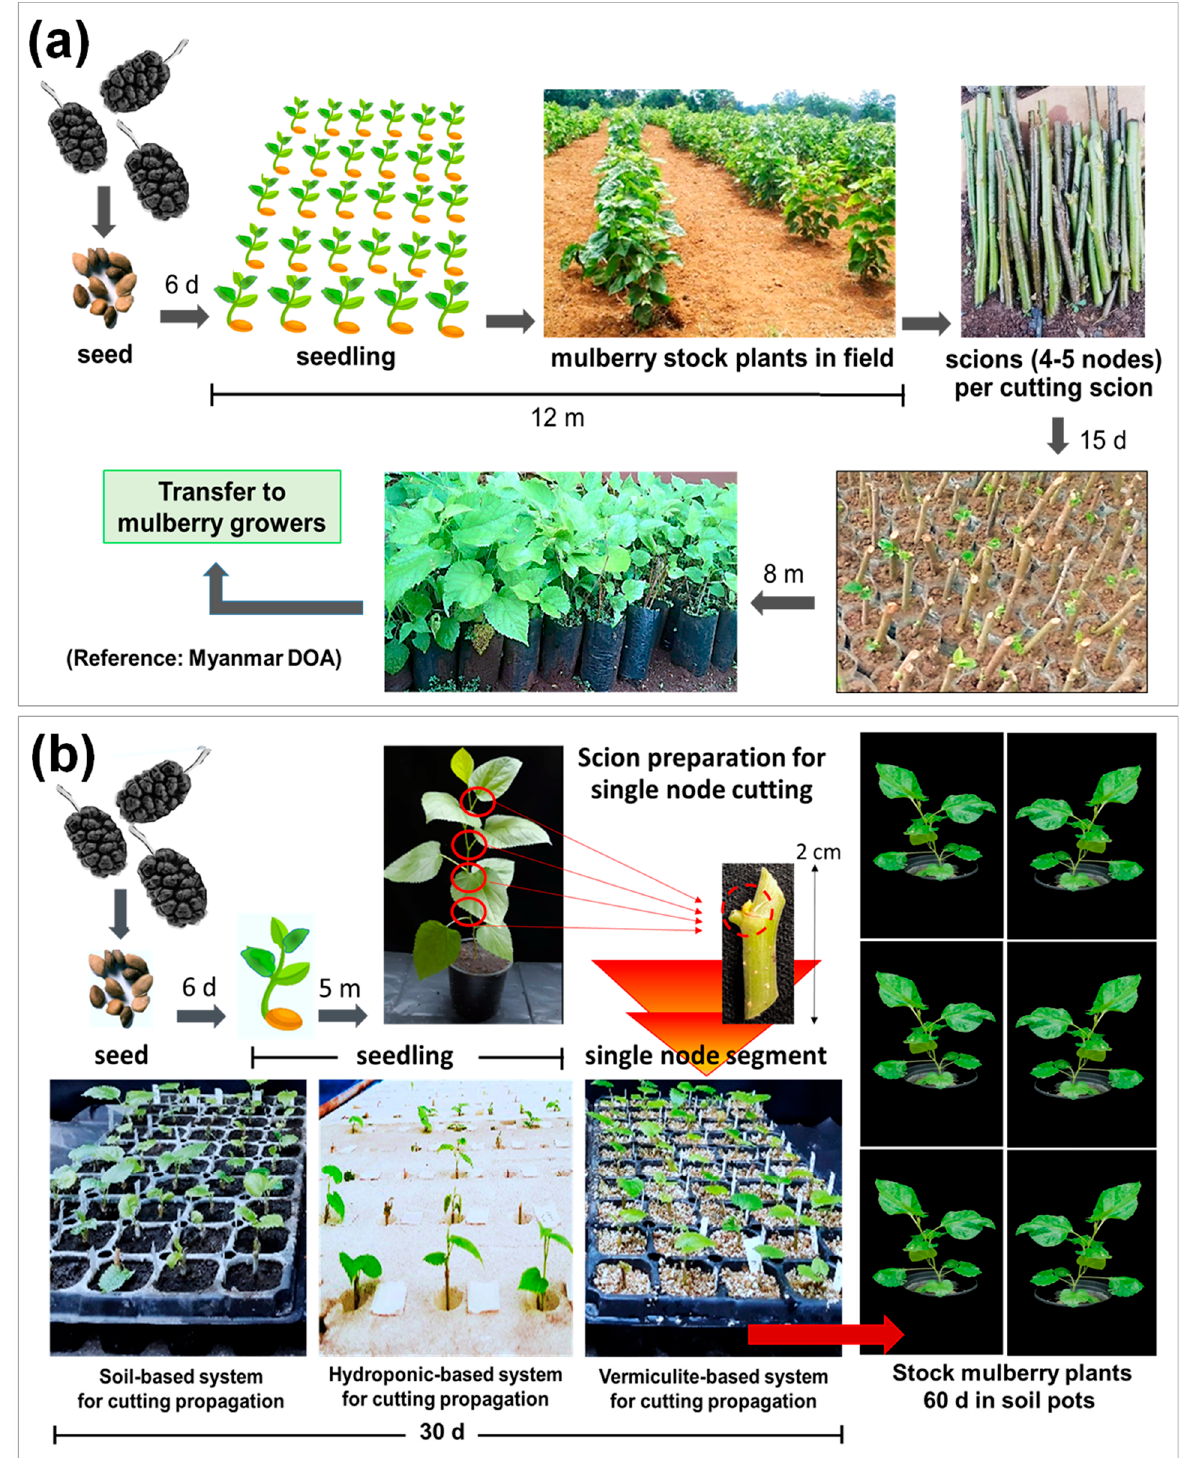
Figure 3. Schematic illustration of mulberry propagation compared between mulberry propagation using softwood stem cutting conventionally suggested by Myanmar DOA ( a ) and the transplants derived from single–node cutting propagation established in this study ( b ).